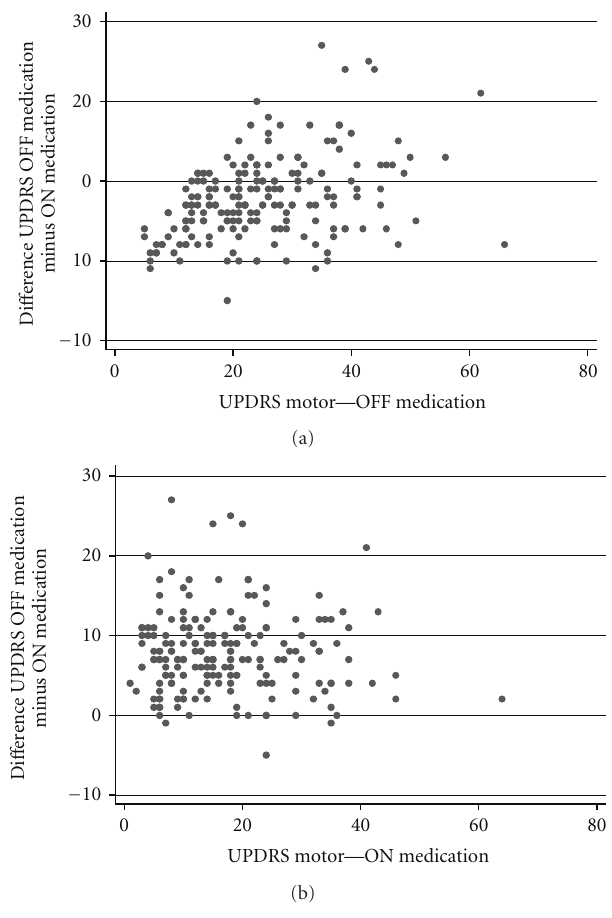
Figure 1: (a) Scatterplot of total Motor UPDRS scores OFF PD medication versus di ff erence in total Motor UPDRS scores OFF medication and ON medication (test of slope P = 0 . 01). (b) Scatterplot of total Motor UPDRS scores ON PD medication versus di ff erence in total Motor UPDRS scores OFF medication and ON medication (test of slope P = 0 .